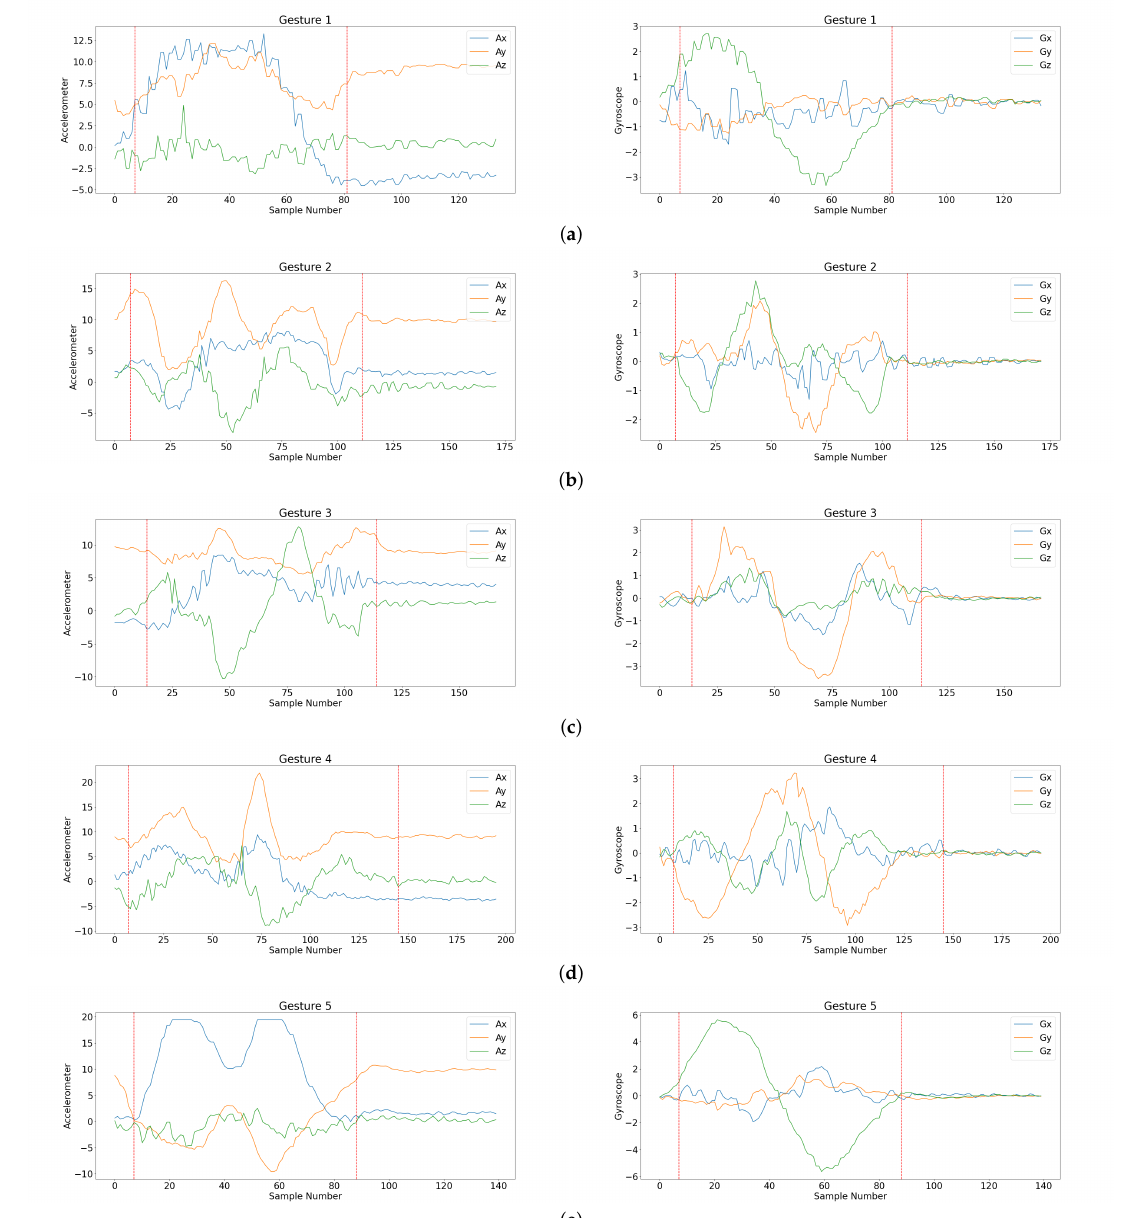
Figure 6. Sensory sequences of foreground gestures (i.e., Gesture 1, Gesture 2, Gesture 3, Gesture 4, Gesture 5 defined in Figure 5) in the training set. The boundary of each gesture is marked in the corresponding sequences. Left column: sensory sequence in three orthogonal axes produced by accelerometer; right column: sensory sequence in three orthogonal axes produced by gyroscope, ( a ) Gesture 1, ( b ) Gesture 2, ( c ) Gesture 3, ( d ) Gesture 4, and ( e ) Gesture